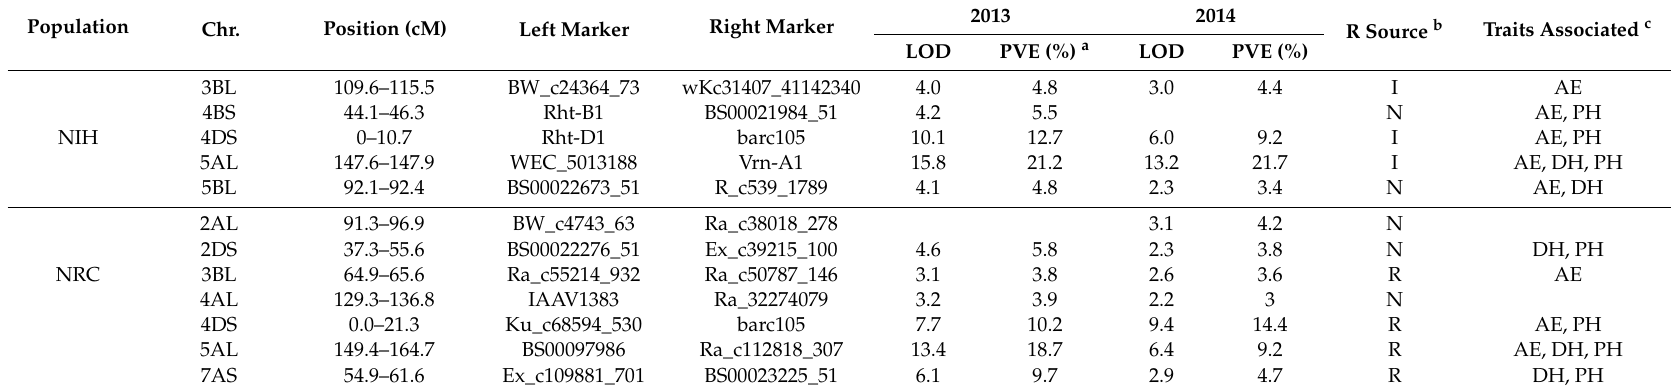
Table 4. QTL for Fusarium head blight (FHB) in “NASMA” × “IAS20*5 / H567.71” (NIH) and “NASMA” × “RPB709.71 / COC” (NRC) populations and their association with other